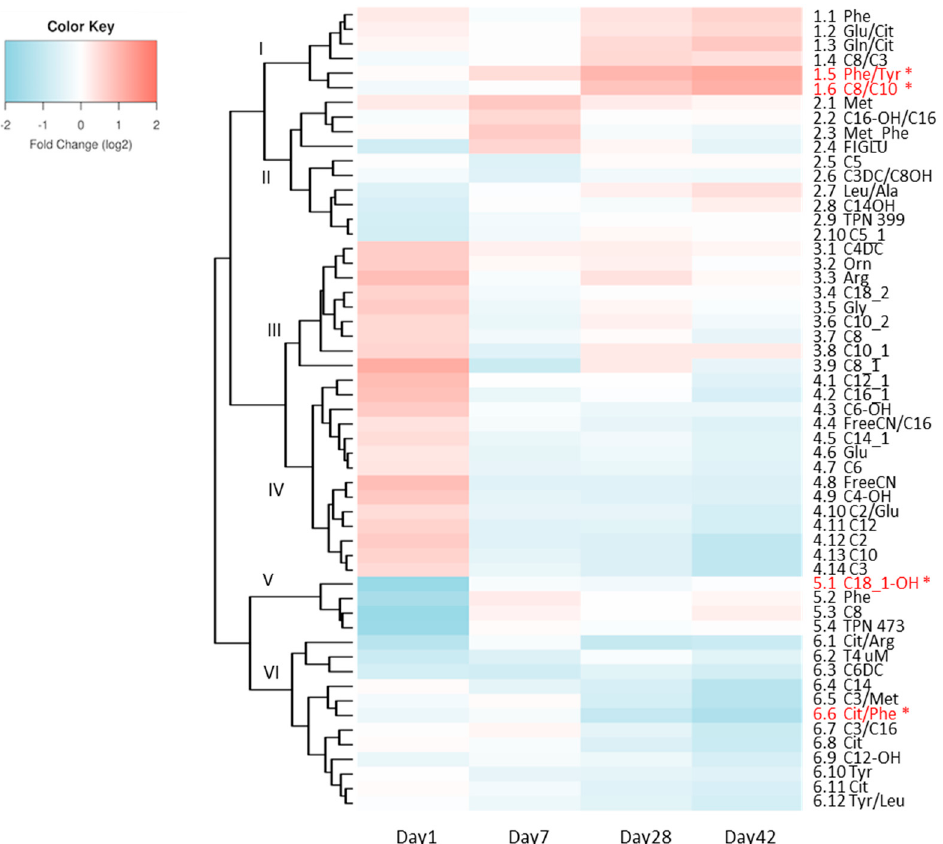
Figure 1. Heat map depicting the fold change in the ratio (log2FC) of all metabolites and respective ratios at each time point. * Metabolites that remained significant in longitudinal modeling after Bonferroni correction are depicted in red.